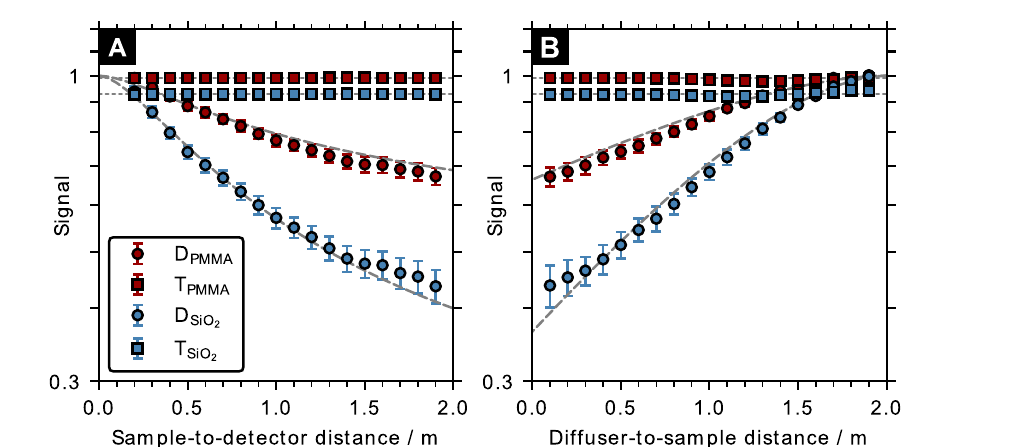
Figure 3. Influence of the sample properties on the dark-field signal. Semi-logarithmic plot of the dark-field (D) and transmission (T) signals’ dependence on sample thickness ( A ; f = 0.05 and d = 4 µ m ), packing fraction ( B ; t = 0.5 mm and d = 4 µ m ) and sphere diameter ( C ; f = 0.05 and t = 4 mm ) for a simulated cubic sample containing an ensemble of glass (SiO 2 ) or PMMA spheres. The dashed and dotted gray lines indicate the theoretical dark-field and transmission signals calculated according to Eqs. (5) and (6).